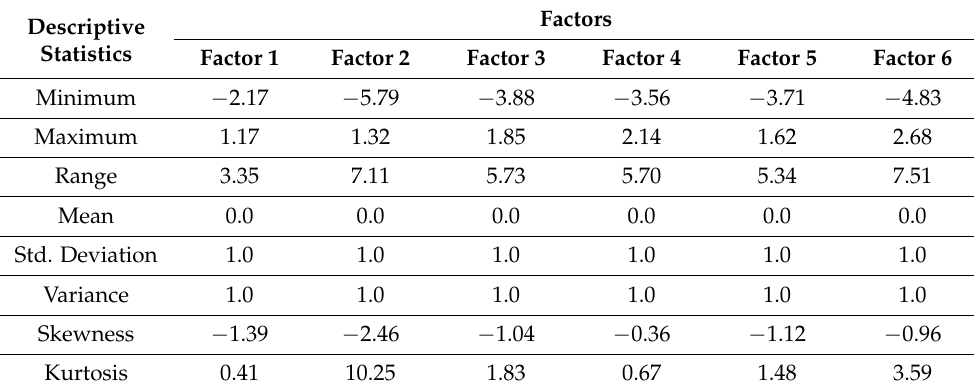
Table 9. Descriptive statistics for all six factors (standardized variables, N = 164). Descriptive